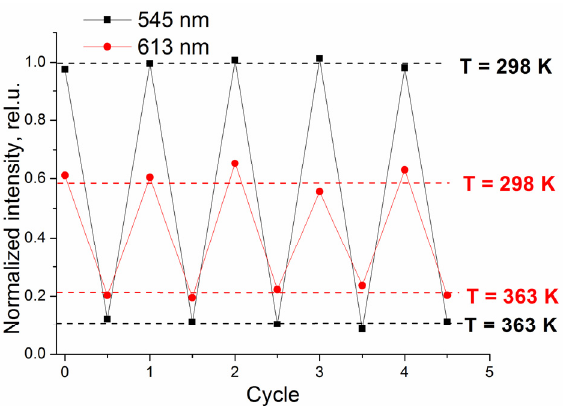
Figure 8. Reversible changes in the luminescence intensity of the 3%Eu5%Tb composite film at λ ex = 330 nm during cycles of heating and cooling between 296 and 363 K.